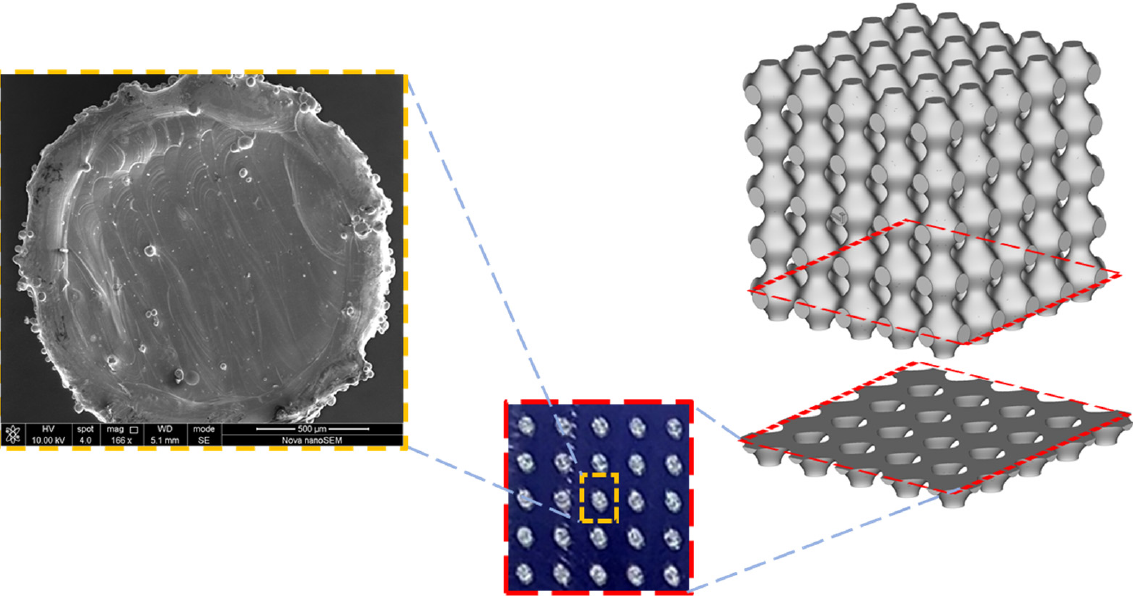
Figure 3. Transverse section of CAD model showing thin layers of printed primitive samples .